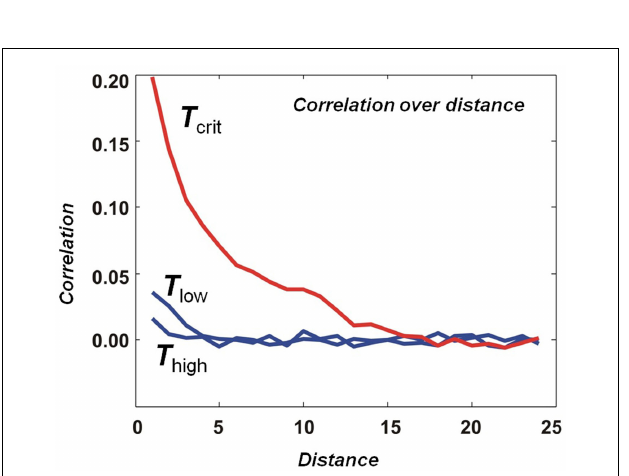
FIGURE 3 |Average dynamic correlation as a function of distance. At high and low temperatures, the average dynamic correlation between two lattice sites decreases rapidly toward 0 as the distance between the lattice sites is increased. At the critical temperature, the average dynamic correlation also decreases toward 0 as the distance is increased, but much more